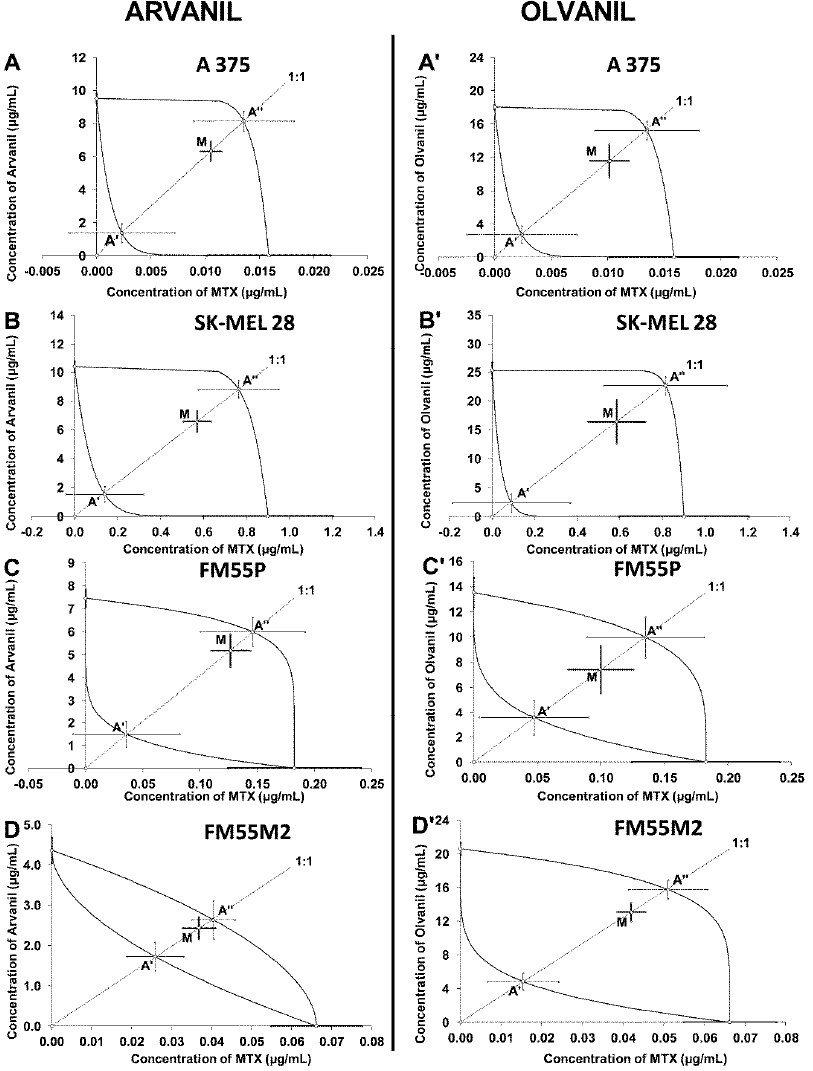
Figure 11. Isobolograms showing interactions between arvanil, olvanil, and mitoxantrone (MTX) with respect to their anti-proliferative effects on A375 ( A , A’ ), SK–MEL 28 ( B , B’ ), FM55P ( C , C’ ), and FM55M2 ( D , D’ ) malignant melanoma cell lines measured in vitro by the MTT assay. Points A’ and A” depict the theoretically calculated IC 50add values for both lower and upper isoboles of additivity, respectively. The points M represent the experimentally derived IC 50mix values for total concentration of the mixture of arvanil or olvanil with MTX that produced a 50% anti-proliferative effect in malignant melanoma cell lines measured in vitro by the MTT